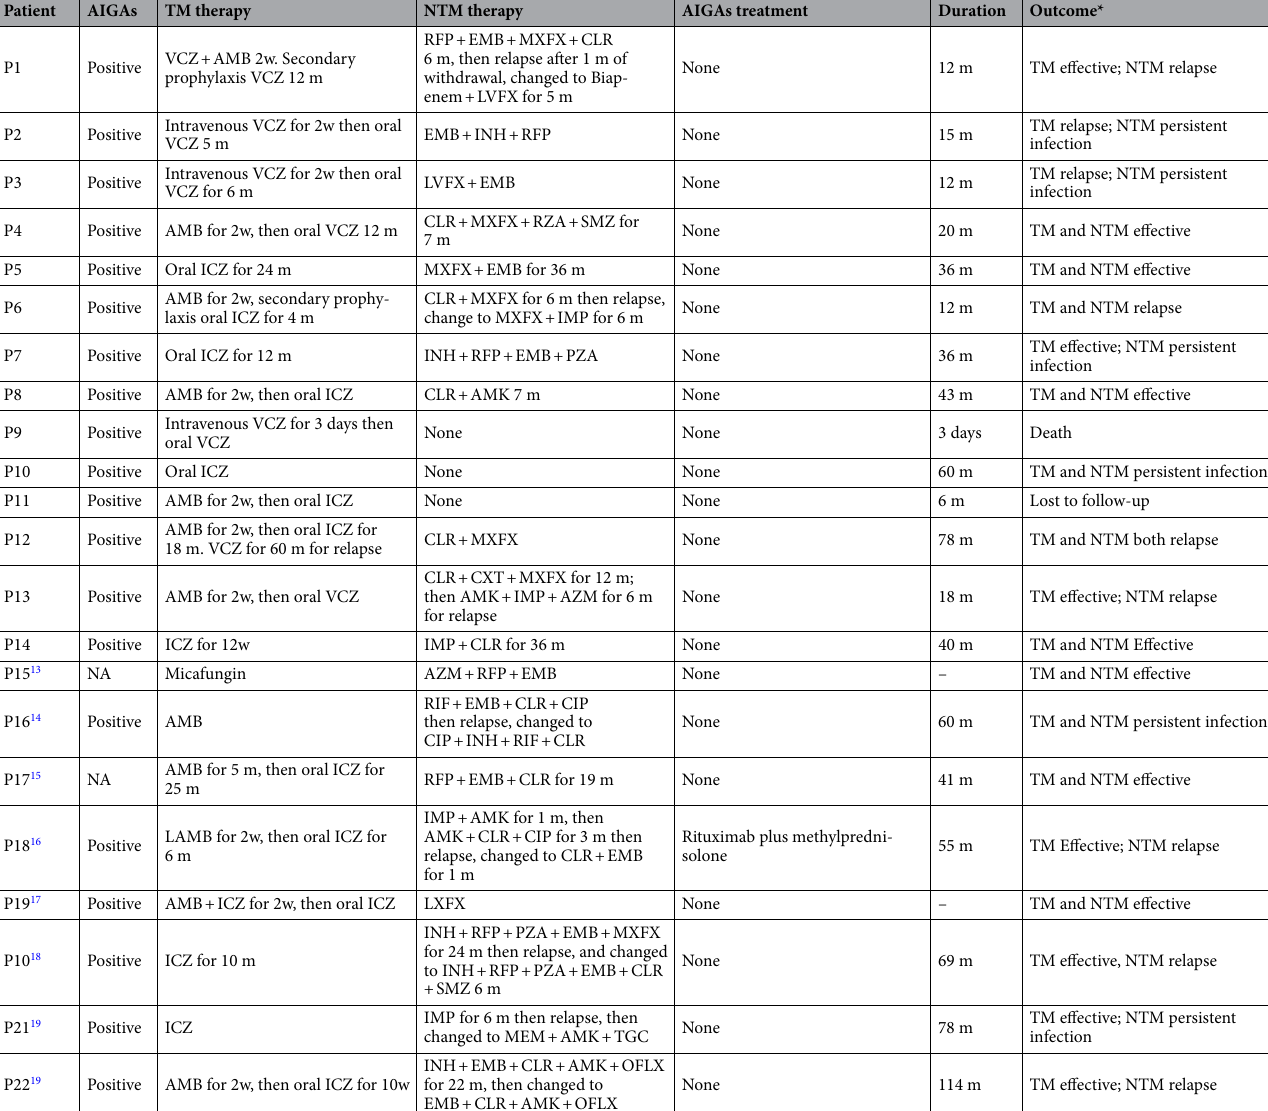
Table 5. Treatment and patient outcomes in Group 1. NA anti-IFN-γ autoantibodies not detected, AMB amphotericin B, LAMB amphotericin B liposome, VCZ voriconazole, ICZ itraconazole, EMB ethambutol, RFP rifampin, CIP ciprofloxacin, INH isoniazid, PZA pyrazinamide, OFLX ofloxacin, CXT cefoxitin, IMP imipenem, AMK amikacin, CLR clarithromycin, LXFX levofloxacin, MXFX moxifloxacin, SMZ sulfamethoxazole, MEM meropenem, TGC tigecycline, AIGAs anti–interferon-γ autoantibodies. *For 14 patients the outcome assessment was performed at their last outpatient follow-up. For 8 patients that were part of the systematic literature review, their outcome assessment was extracted from the literature. For the following patients, the duration between the time the treatment was stopped, and the outcome assessment was respectively: 12 months for P15; 19 months for P16; 10 months for P18; 12 months for P19; and 6 months for P22. For the following patients, the outcome assessment time was performed when they were discharged: P17, P21, and